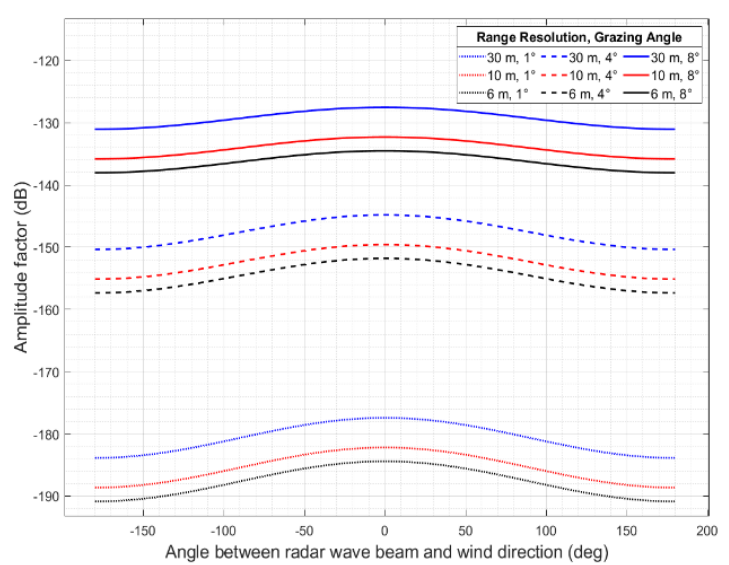
Figure 6. Amplitude factor of sea clutter.